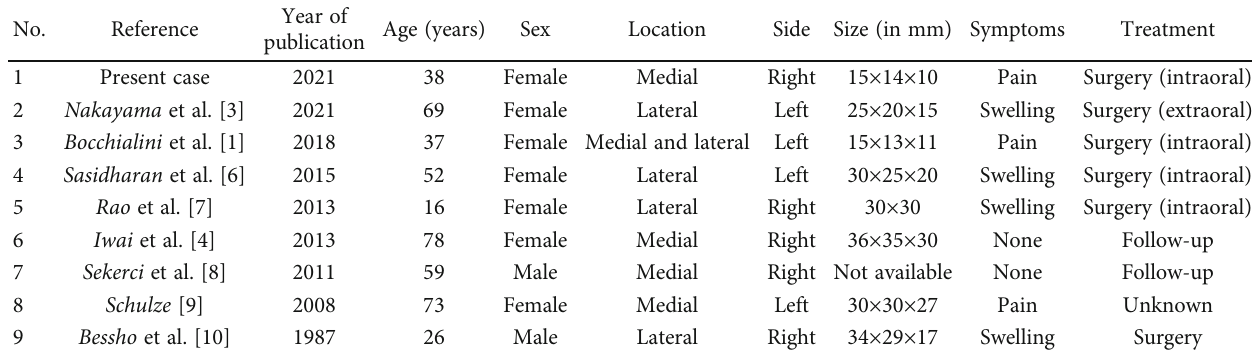
Table 1: Reported cases of peripheral osteoma in the mandibular